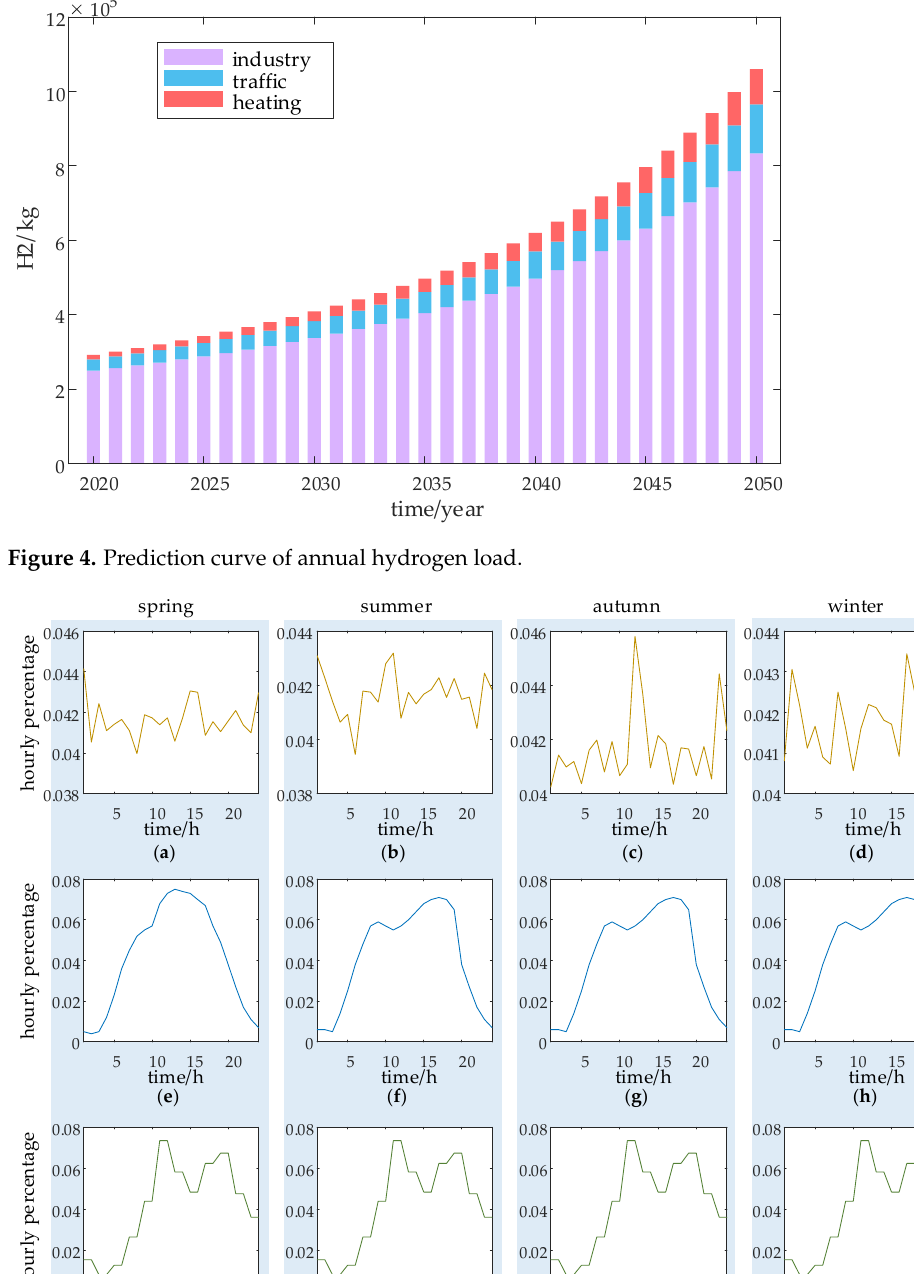
Figure 6. Forecasted annual electrical load from 2020 to 2050.